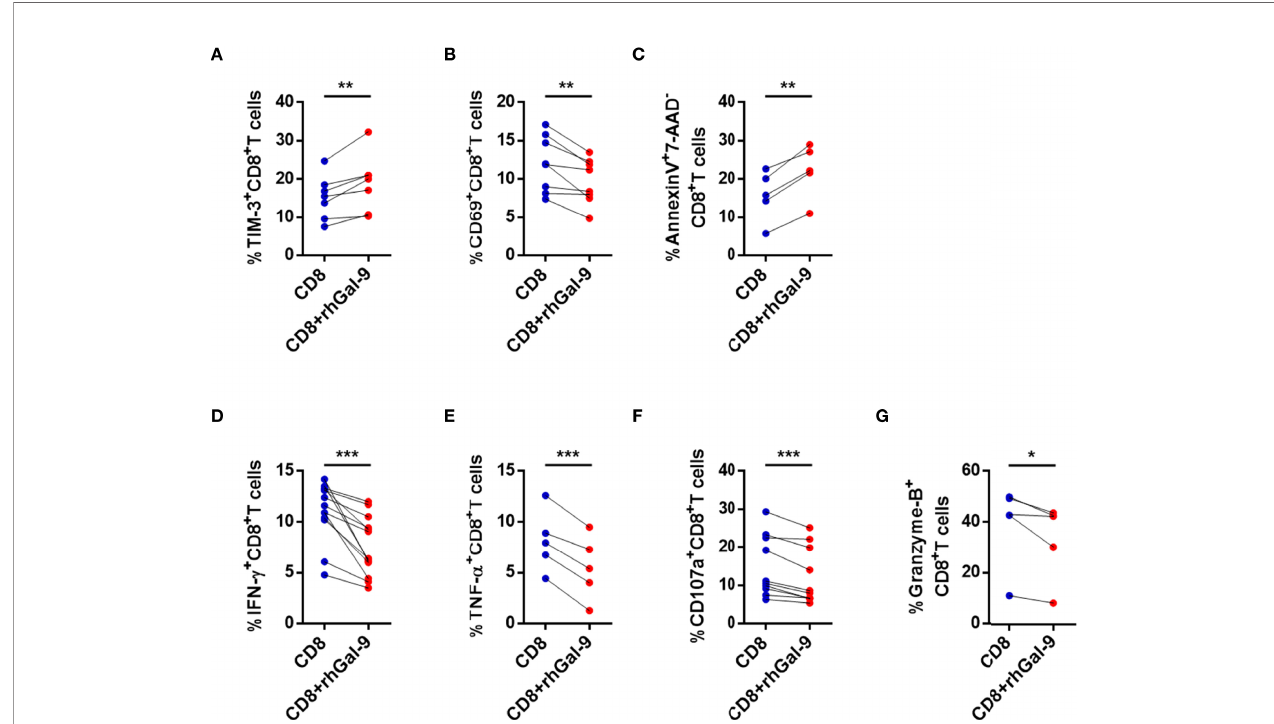
FIGURE 5 | Exogenous Gal-9 induces circulating CD8 + T cell exhaustion in active CHB patients. (A – G) Coculture of CD8 + T cells from active CHB patients and rhGal-9 for 3 days and stimulation with anti-CD3/anti-CD28. (A) The percentage of TIM-3 + CD8 + T cells after culture with or without rhGal-9. (B) The percentage of CD69 + CD8 + T cells after culture with or without rhGal-9. (C) Comparison of CD8 + T cell early apoptosis after culture with and without rhGal-9. (D – G) Comparison of the expression of IFN- g , TNF- a , CD107a, and granzyme B in CD8 + T cells from active CHB patients after culture with and without rhGal-9. Results are expressed as the mean ± SEM, and the number of samples (n) in each group was ≥ 3. A paired t-test was used to compare paired samples. *P < 0.05; **P < 0.01; ***P < 0.001.